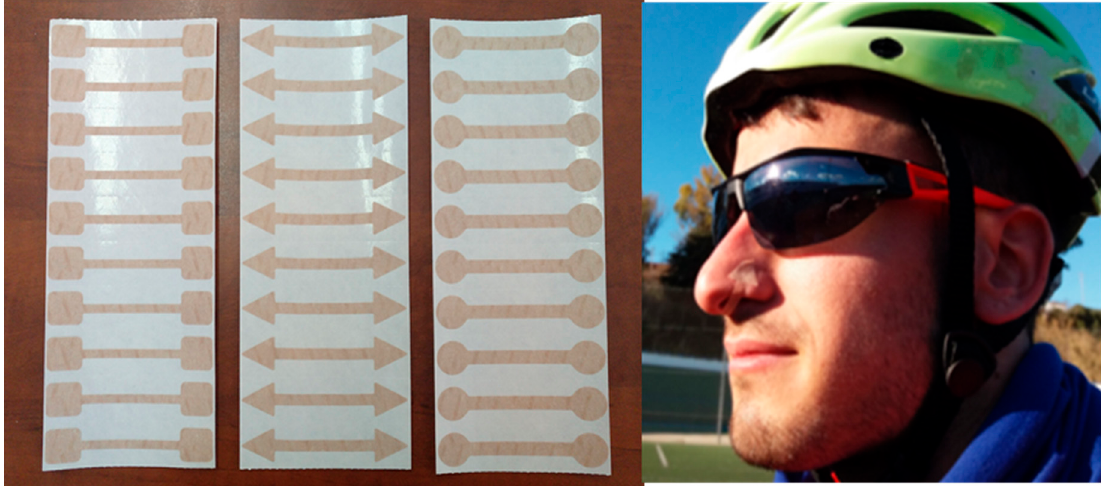
Figure 1. FeelBreathe (FB) devices of 4, 5 and 6 mm arranged in sheets of 10 units. FB placement mode under the nostrils.